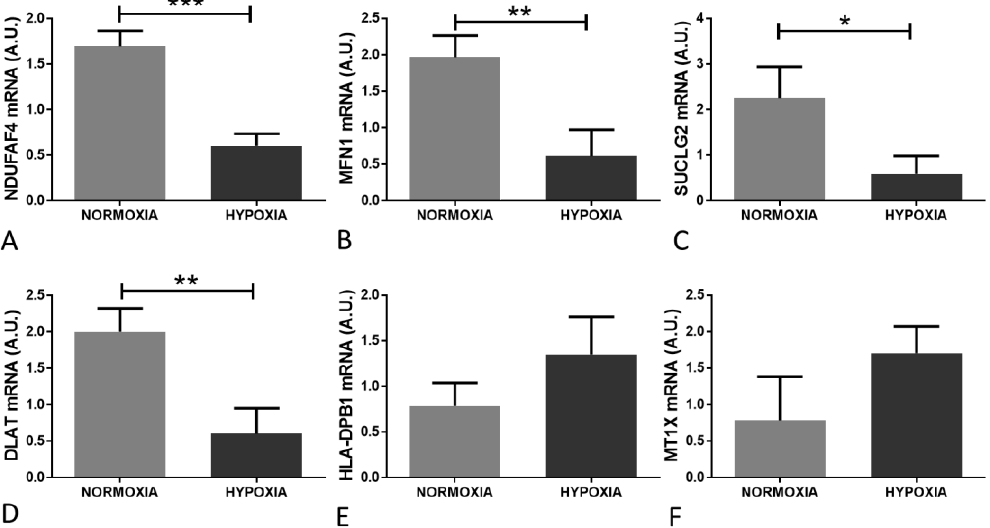
Figure 6. qPCR validation of hypoxia induced gene expression changes in human astrocytes. qPCR confirmed a significant downregulation of ( A ) NDUFAF4 ( p = 0.001), ( B ) MFN1 ( p = 0.007), ( C ) SUCLG2 ( p = 0.02), ( D ) DLAT ( p = 0.007); and a non-significant upregulation of ( E ) HLA-DPB1 ( p = 0.11) and ( F ) MT1X ( p = 0.08) in response to hypoxia. * p ≤ 0.05, ** p ≤ 0.01, *** p ≤ 0.001.